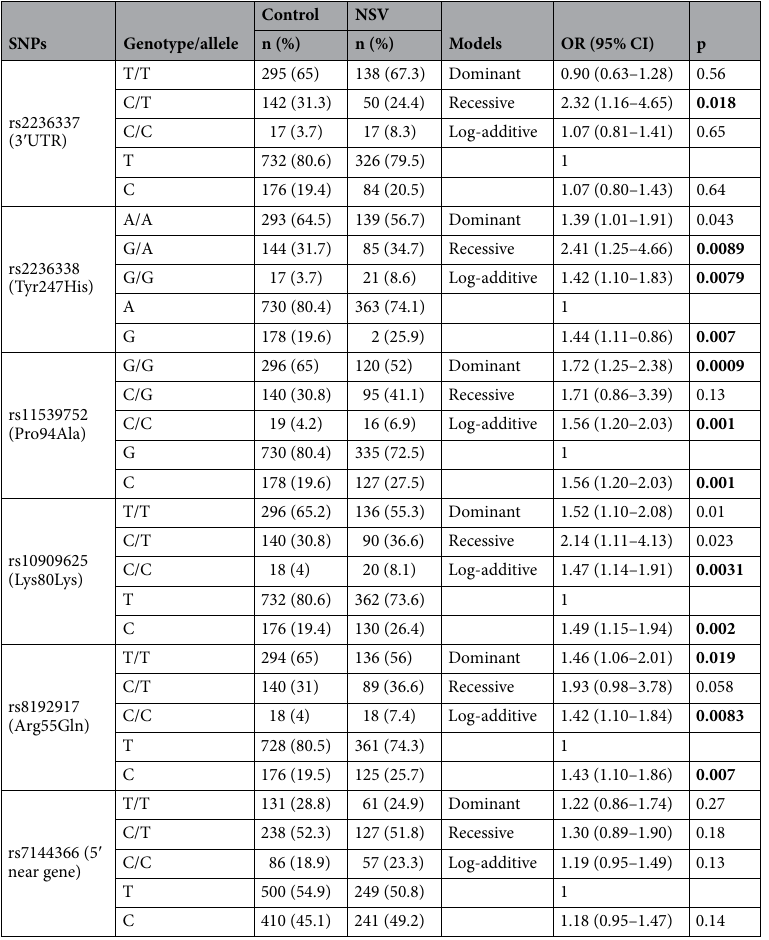
Table 1. Genotype and allele frequencies of GZMB SNPs in the control and the NSV groups. GZMB granzyme B, SNP single nucleotide polymorphism, NSV nonsegmental vitiligo, n number of subjects, OR odds ratio, CI confidence interval. Bold numbers indicate significant association. Missing genotype data were omitted for accurate